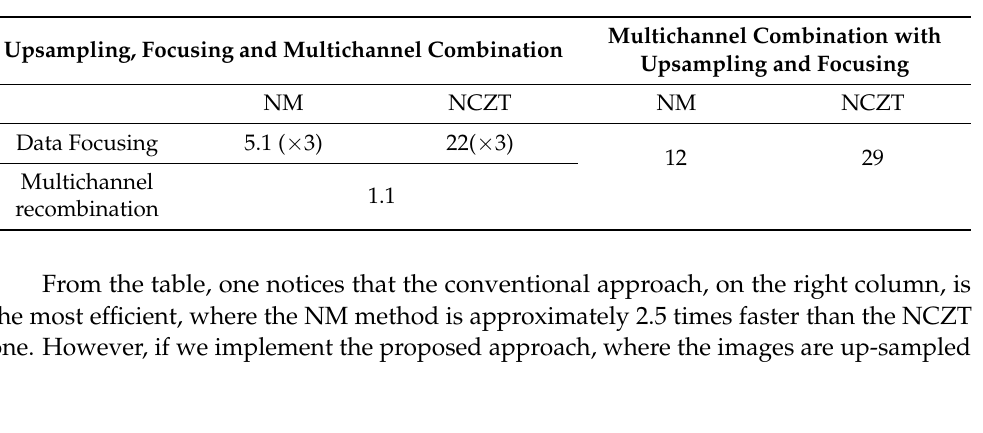
Table 3. Computing times, in seconds, measured for the MATLAB prototypes of the various process- ing